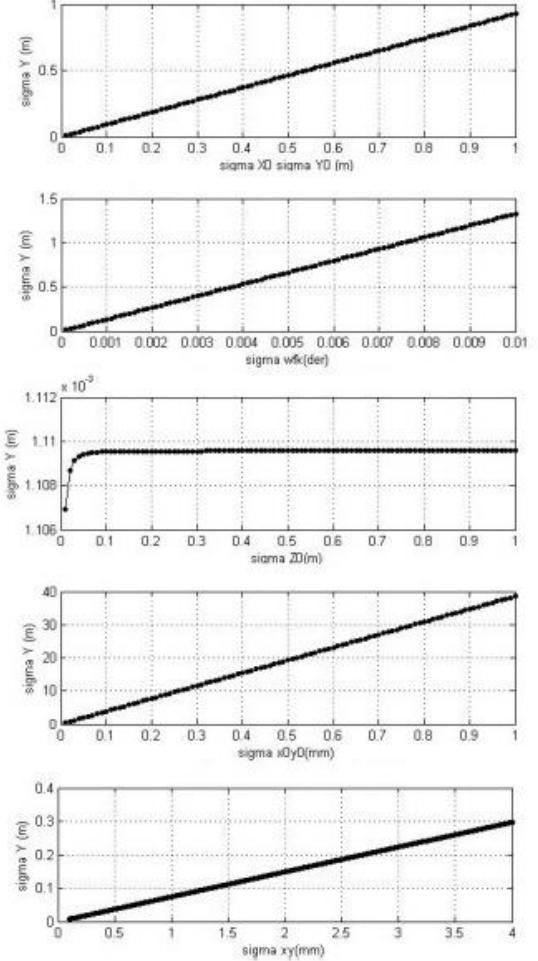
Figure 5.b Effect of orientation parameters on Y component